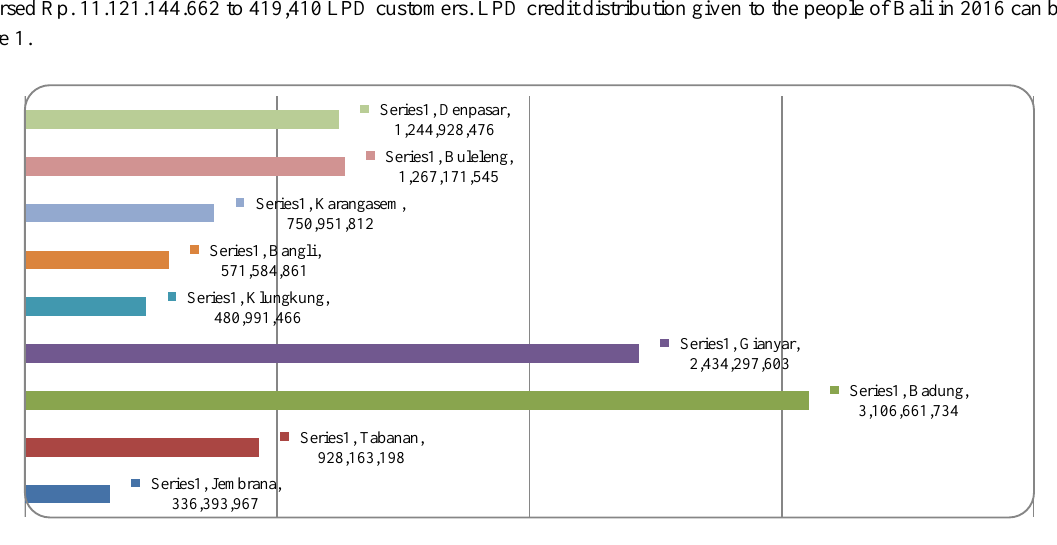
Fig. 1: The total amount of LPD credit in Bali is disbursed to its customers ; Source: Empowering Institute of LPD of Bali Province,